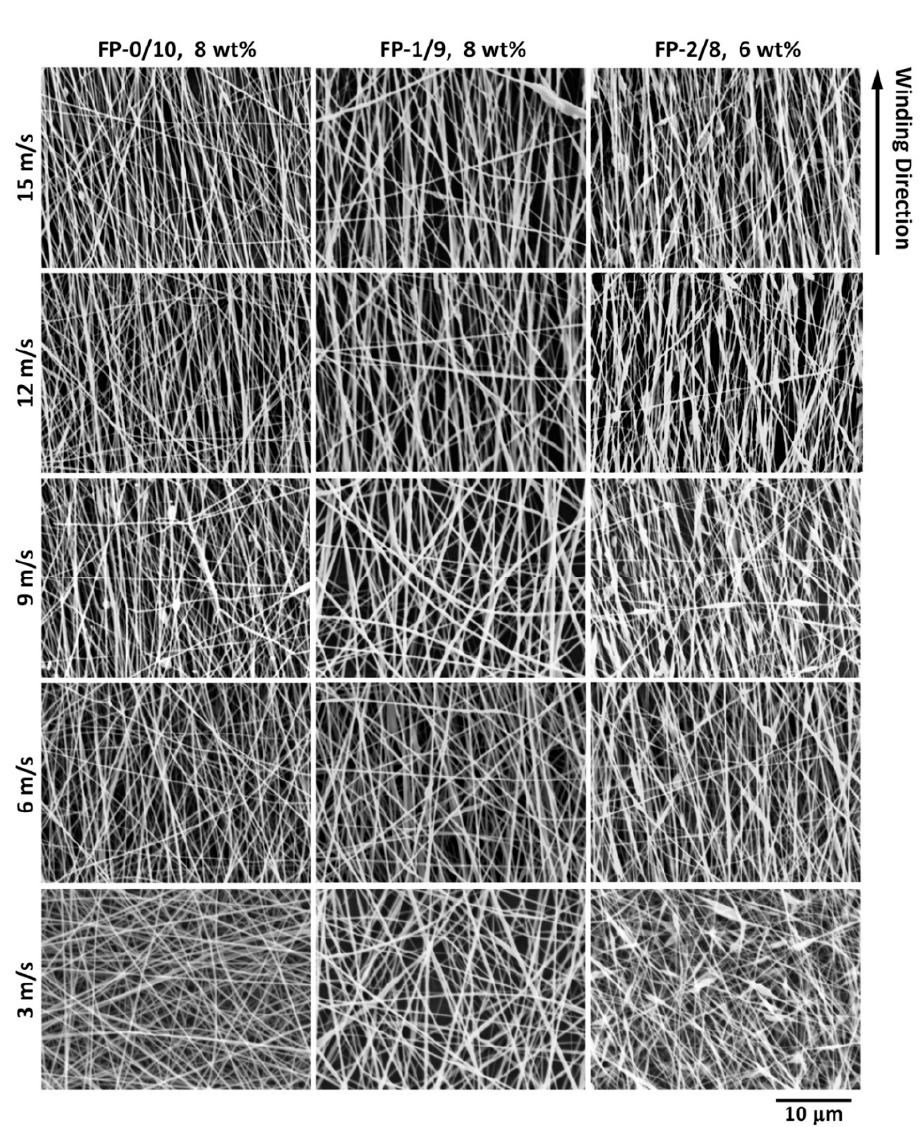
Figure 2. Oriented fibers produced from the spinning dopes of FP-0/10 at 8 wt%, FP-1/9 at 8 wt%, and FP-2/8 at 6 wt% were collected at rotational speeds of 3, 6, 9, 12, and 15 mm/s. To numerically show the orientation intensity, the images in Figure 2 were shifted to binary images (Figure S2, supporting information), followed by a Fourier transform